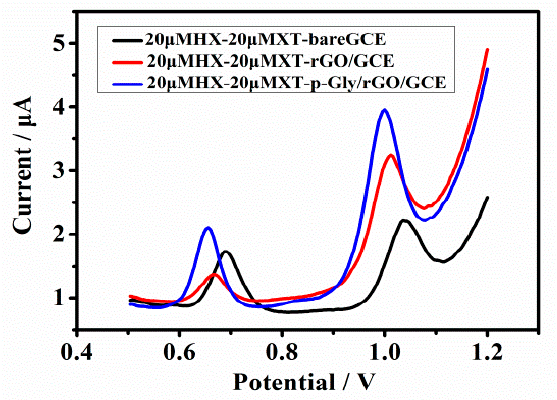
Figure 3. DPV curves of bare GCE, rGO/GCE and p-Gly/rGO/GCE after adding 20 μM XT and 20 μM HX in 0.1 M PBS (pH 7.0).